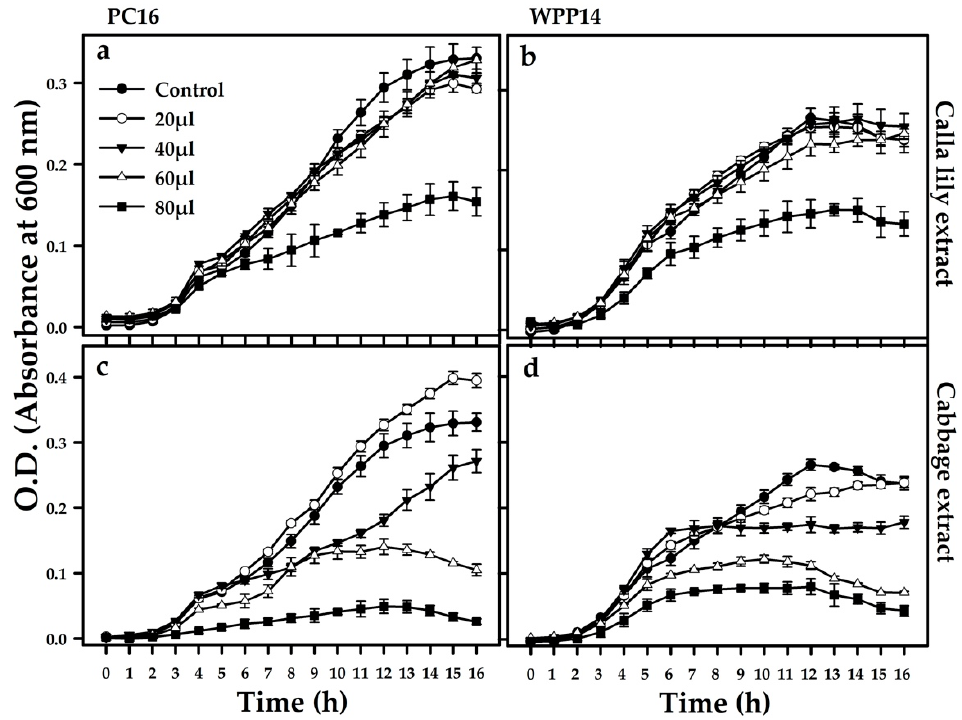
Figure 5. Effect of phenolic extracts from calla lily or cabbage leaves on the growth of Pectobacterium strains PC16 ( a , c ) and WPP14 ( b , d ). Bacteria were grown at 28 ° C for 16 h, with or without plant extract, under continuous shaking (150 rpm). Growth was assessed every hour and is presented as absorbance at 600 nm (OD 600 nm ). Experiments were repeated twice with four replicates per treatment; similar results were observed in the two repetitions (bar = mean ± SE; n = 8).